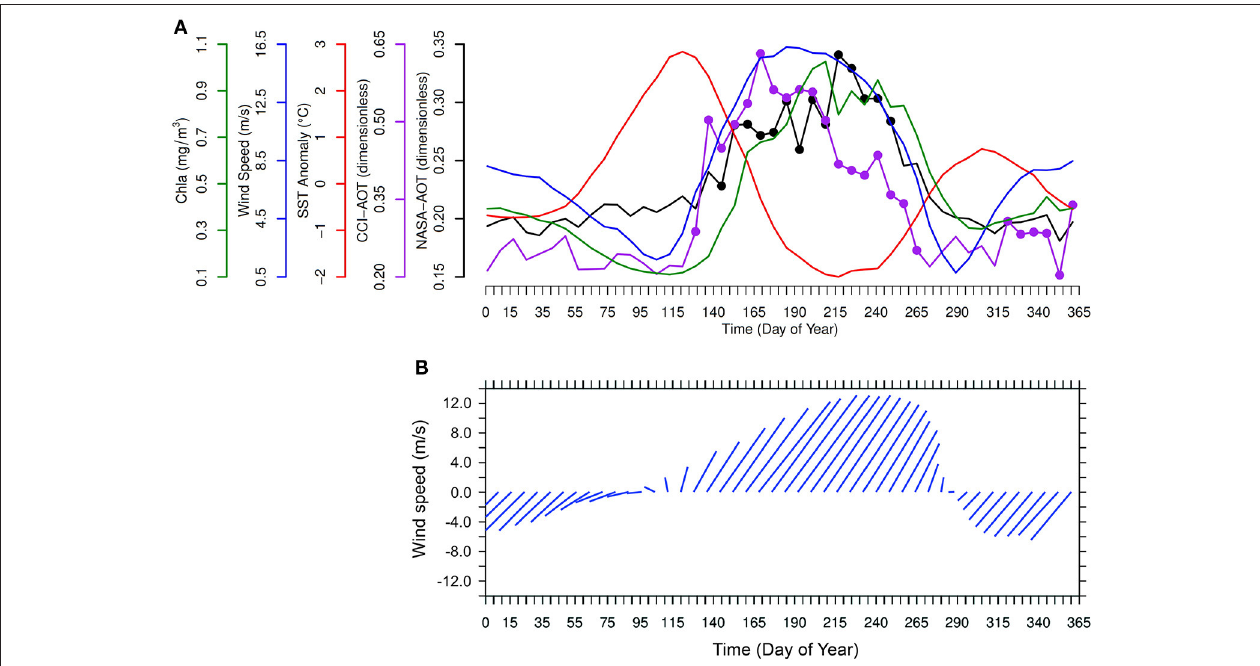
FIGURE 3 | Time series of 8-day climatology, (A) for Chl-a, NASA-AOT, CCI-AOT, SST anomaly and Wind speed and (B) for the wind vectors. The black and purple coloured dots in the NASA-AOT and CCI-AOT graph denote the presence of dust aerosols.